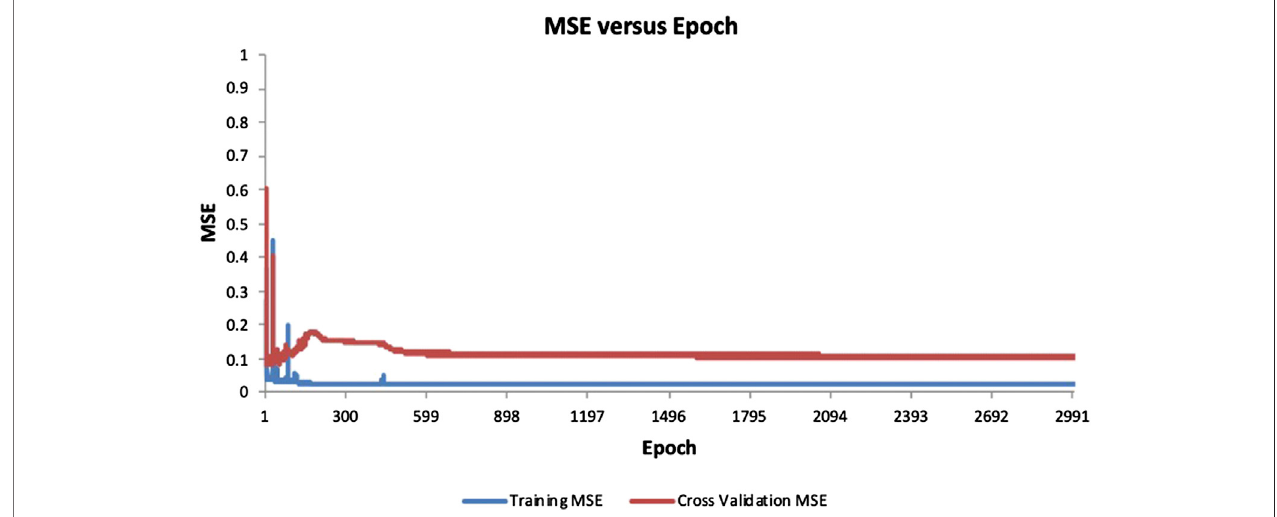
FIGURE 9 | ANN model (2-5-5 – 1) training and validation